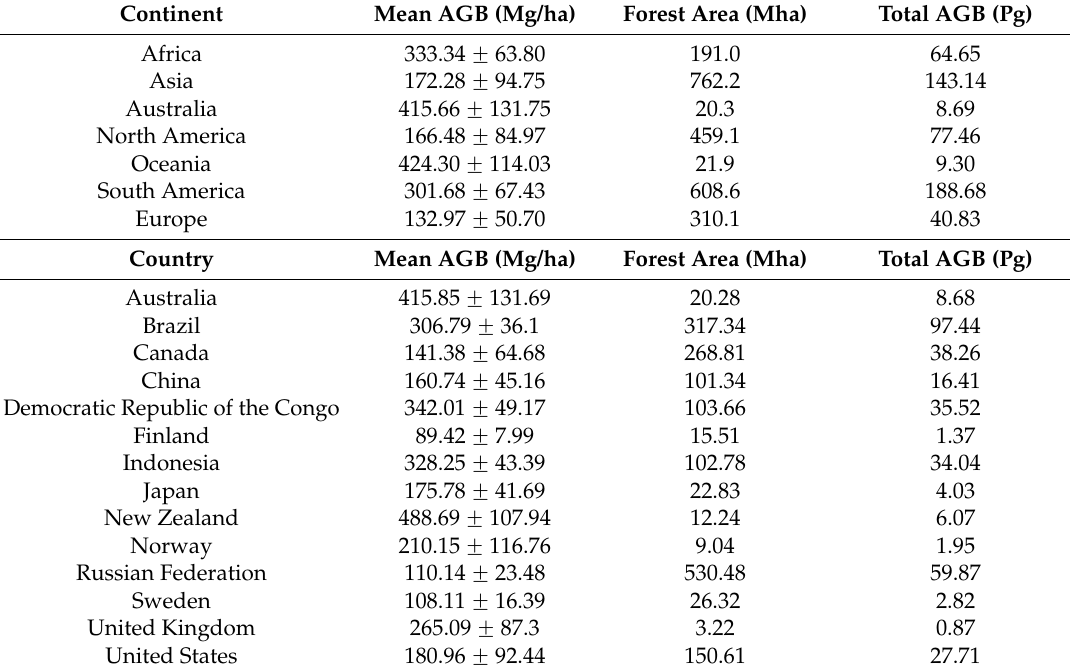
Table 3. The continental-level and national-level forest AGB density and biomass stock in this study.